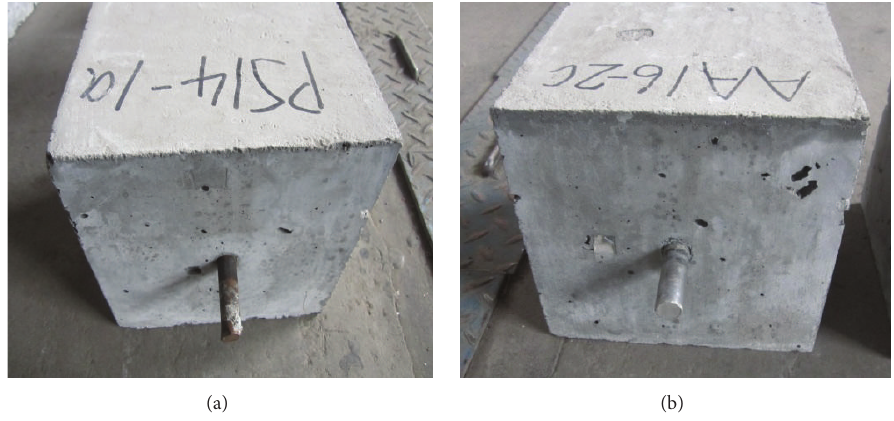
Figure 3: Pullout failure of plain bars specimens: (a) steel bar and (b) Al-alloy.